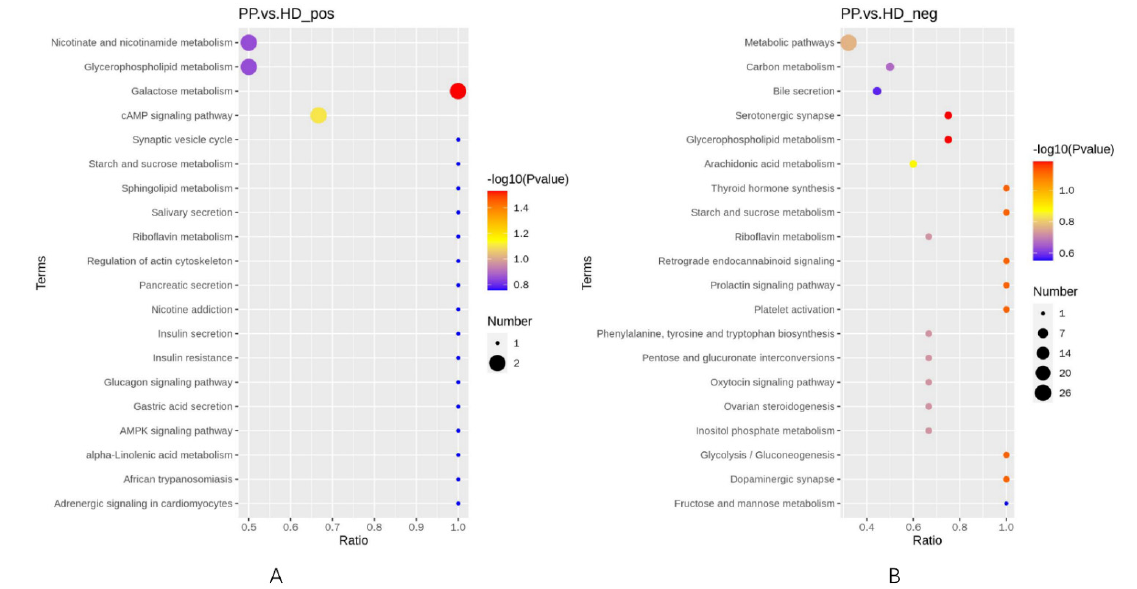
Figure 5. Significantly changed pathways based on the enrichment analysis. ( A ). KEGG enrichment bubble plot under the positive mode; ( B ). enrichment bubble plot under the negative mode.